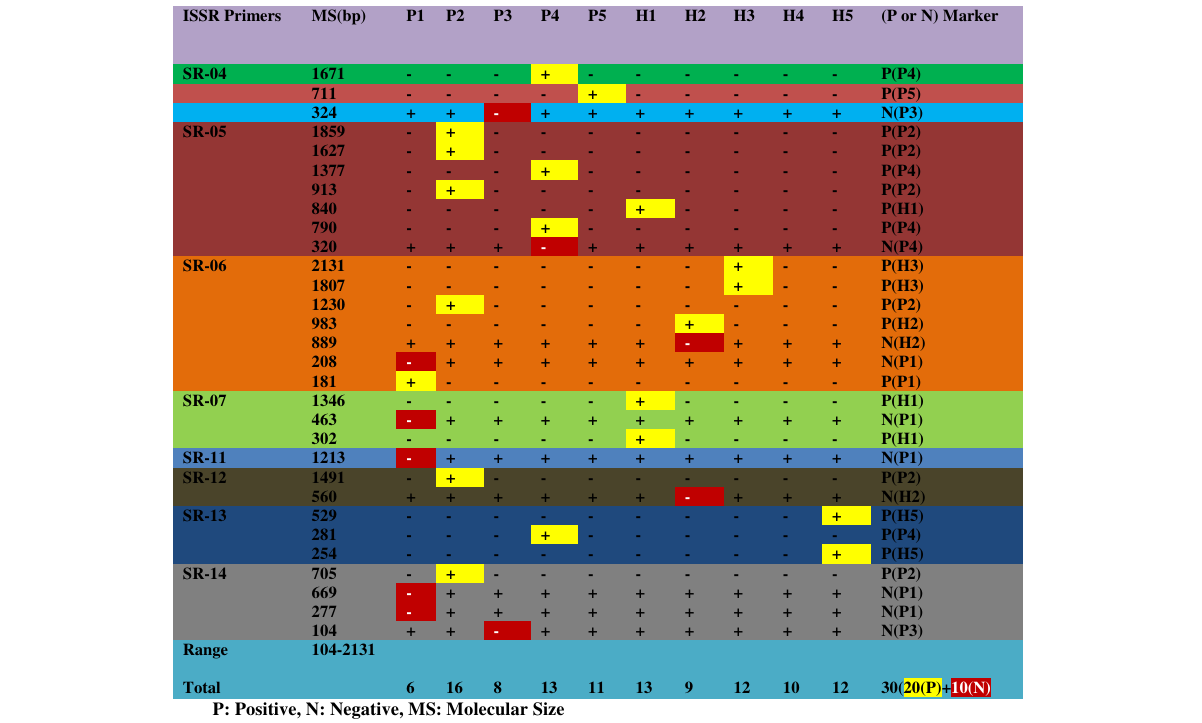
Table 12 Mapping of positive (P) and negative specific markers for the 10 sorghum genotypes using eight ISSR primers ISSR Primers